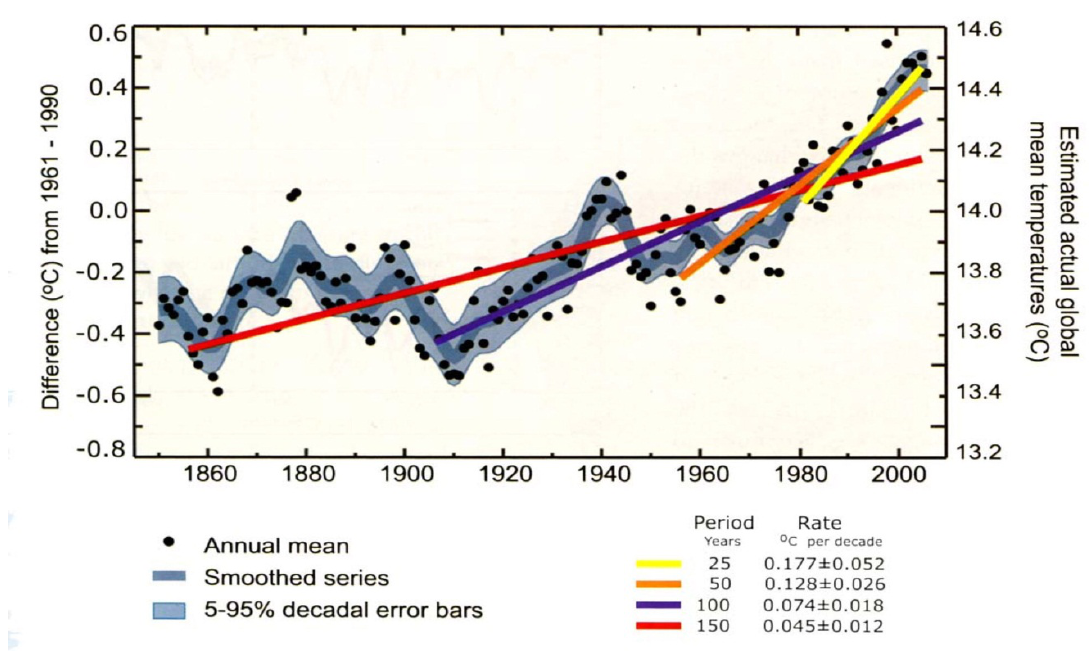
Figure 1. Global average temperature changes [2]. The rate of increase in temperature is estimated for several different time